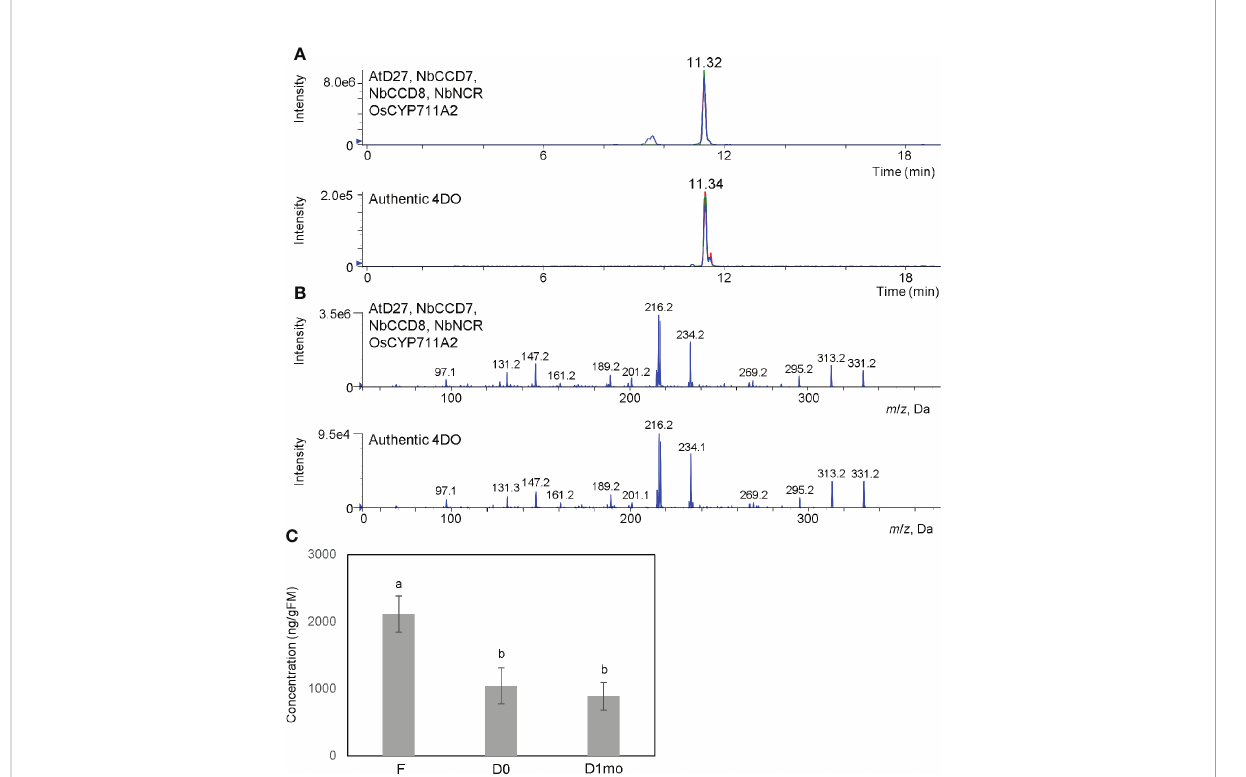
FIGURE 3 High accumulation of 4DO and suppression of degradation of 4DO in N. benthamiana . (A) Detection of 4DO in N. benthamiana leaves. Leaves were in fi ltrated with an Agrobacterium mixture containing pBYR2HS-AtD27, -NbCCD7, -NbCCD8, -OsCYP711A2, and -NbNCR. After in fi ltration, leaves were applied with 200 mM sodium ascorbate by a foliar spray. Seven days after in fi ltration, leaf extracts were analyzed by LC-MS/MS. Multiple reaction monitoring chromatograms of 4DO (blue, 331.15/97.00; red, 331.15/216.00; green, 331.15/234.00; m/z in positive mode) by LC-MS/MS are shown. (B) Product ion spectra of 4DO in N. benthamiana leaves expressing pBYR2HS-AtD27, -NbCCD7, -NbCCD8, -OsCYP711A2, and -NbNCR. Product ion spectra derived from the precursor ion [M+H] + ( m / z 331) of the peak at the retention time 11.32 min and authentic 4DO are shown. (C) The levels of 4DO production. Seven days after in fi ltration, one gFM of leaves was immersed into acetone and content of 4DO was measured (F). One gFM of leaves was incubated at 80°C for 16 h (D0). After incubation at 80°C, dried leaves were left at room temperature for 1 month (D1mo). These samples were analyzed by LC-MS/MS and area intensities of 4DO are calculated. Values represent the means ± SE (n = 3) from a representative of three biological replicates. Accumulation of 4DO in N. benthamiana was much higher than in rice d14 mutant (152 ng/gFM), and a high amount of 4DO still remained 1 month after in fi ltration. The letters on the top of the error bars indicate the statistically signi fi cant differences between F and D0 or D1mo according to Tukey-Kramer ’ s test (P < 0.05). The same letter indicates no signi fi cant